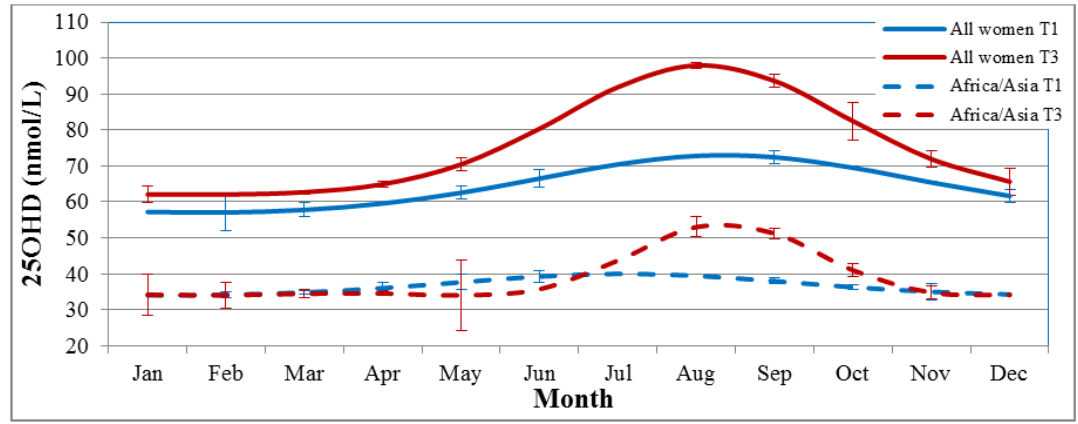
Figure 1. The four cosine functions fitted to the 25(OH)D concentrations at T1 and T3, for the whole cohort and the subgroup born in Africa and Asia. Error bars show the standard deviations of the predicted vs. crude mean 25(OH)D per month. 25(OH)D, 25-hydroxyvitamin D; T1, first trimester; T3, third trimester.